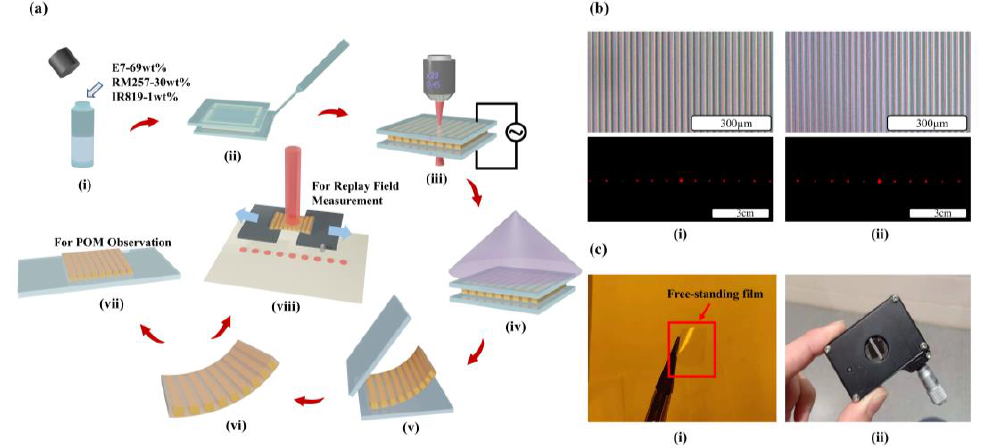
Figure 5. A stretchable one-dimensional diffraction grating in a liquid crystal (LC) gel. ( a ) Illustration of the fabrication and measurement process used to construct and characterize the mechanically stretchable grating: (i) mixture preparation, (ii) capillary filling of glass cell, (iii) fabrication of a 1-D diffraction grating with a voltage applied to the LC cell, (iv) bulk photo-polymerization of the film using ultraviolet illumination, (v) delamination of the cell to form a free-standing LC film that is approximately 20 µm thick, (vi) extraction of the flexible film, (vii) polarising optical microscope (POM) observation of the film, (viii) far (Replay) field observation of the diffraction pattern. ( b ) The POM (top) and far (replay)-field (bottom) images of the phase grating before (i) and after (ii) delamination. ( c ) Photographs of the LC free-standing film: (i) after delamination and (ii) mounted on an adjustable slit for stretchability and reversibility measurements.